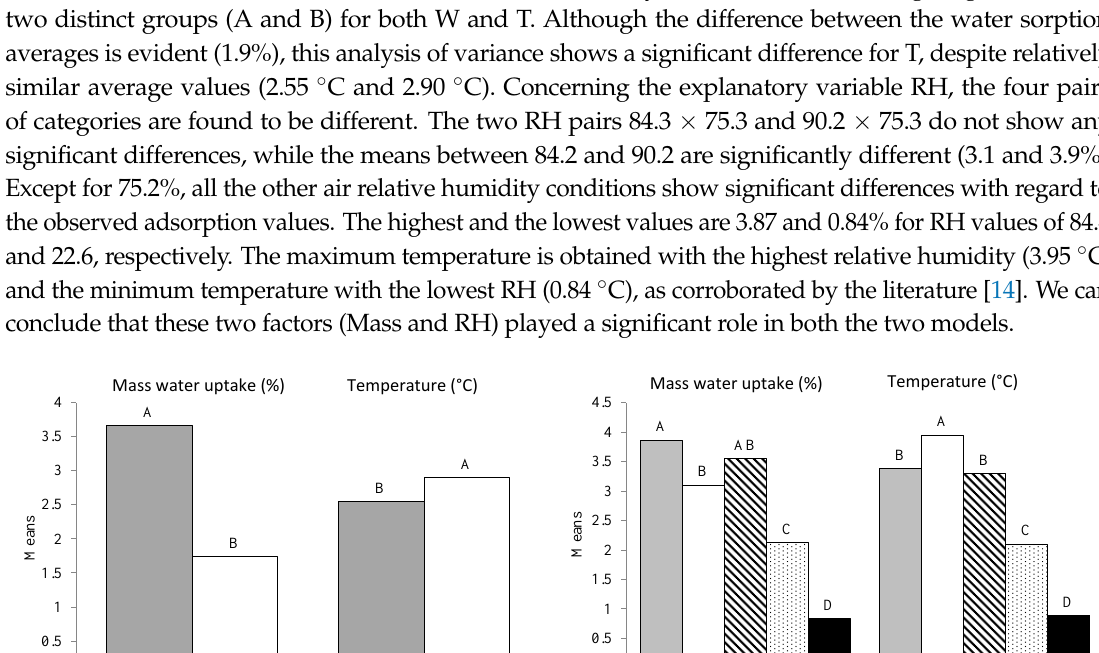
Figure 7. Second order interactions multiple comparisons according to the Tukey test. The means with the same letter were not significantly different at 5% (α = 0.05). Lump = piece. The last common parameter to W and T models is the third order interaction Size × Biochars × Mass. Table 8 gives the average value classified by the Tukey test. The variable T presents seven groups and W only four groups. The temperature variable is more sensible to this interaction than